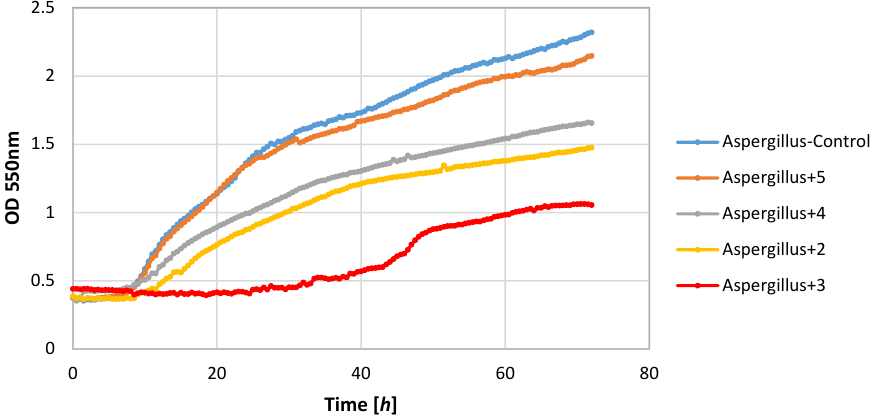
Figure 4. The assessment of the effects of the lactones 2 – 5 on the growth of A.niger. (OD-Optical Density was measured for λ 550 nm).